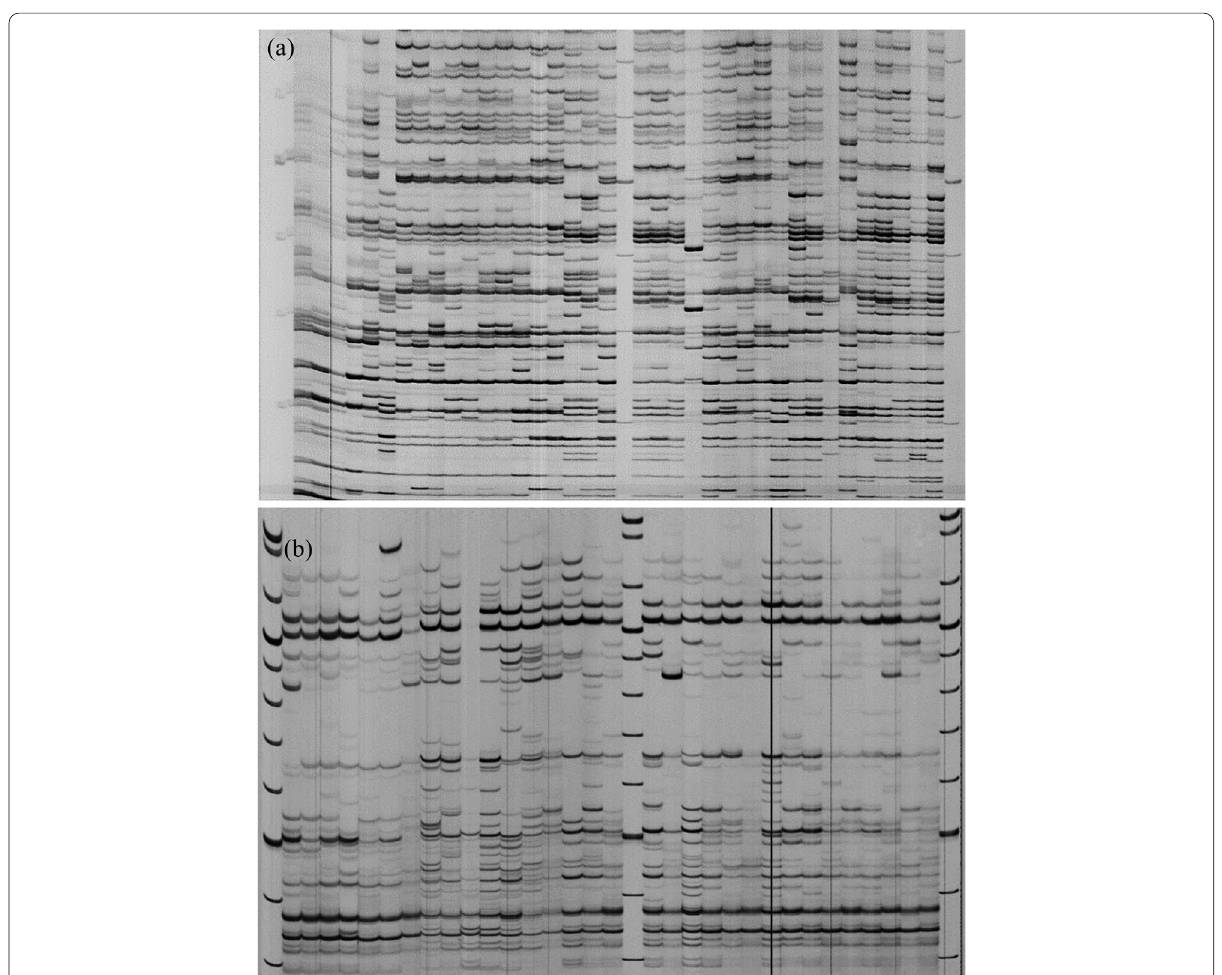
Fig. 1 Polyacrylamide gel profile of Ae. tauschii accessions using a 5 ′ LTR in IRAP and b ISSR6